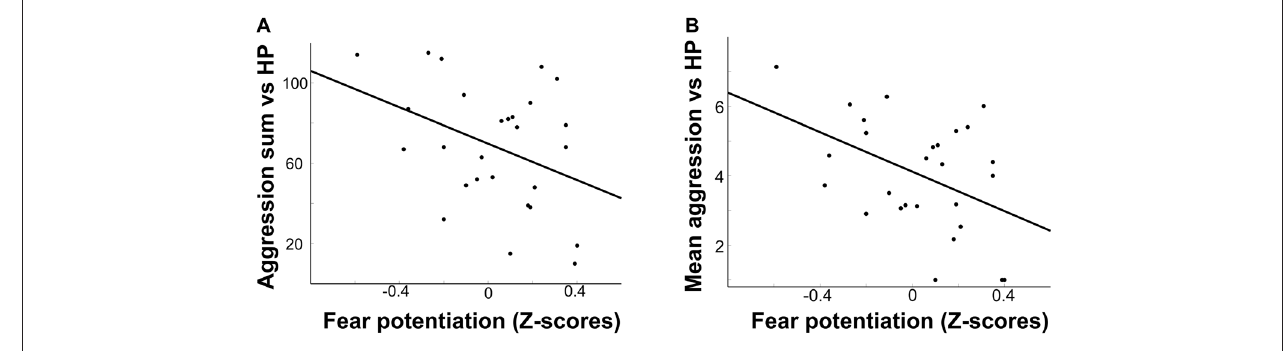
FIGURE 2 | Scatterplots depicting the negative correlations between Fear Potentiation (FP) and aggression sum scores (A) , and between FP and mean aggression (B) against the highly provoking opponent